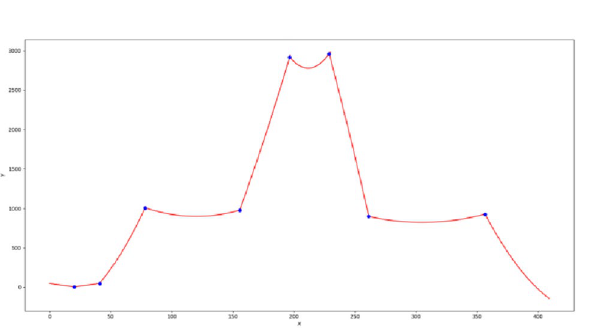
Figure 5. A renderings of all fitting results with the intersection point of fitting function equations as the splicing